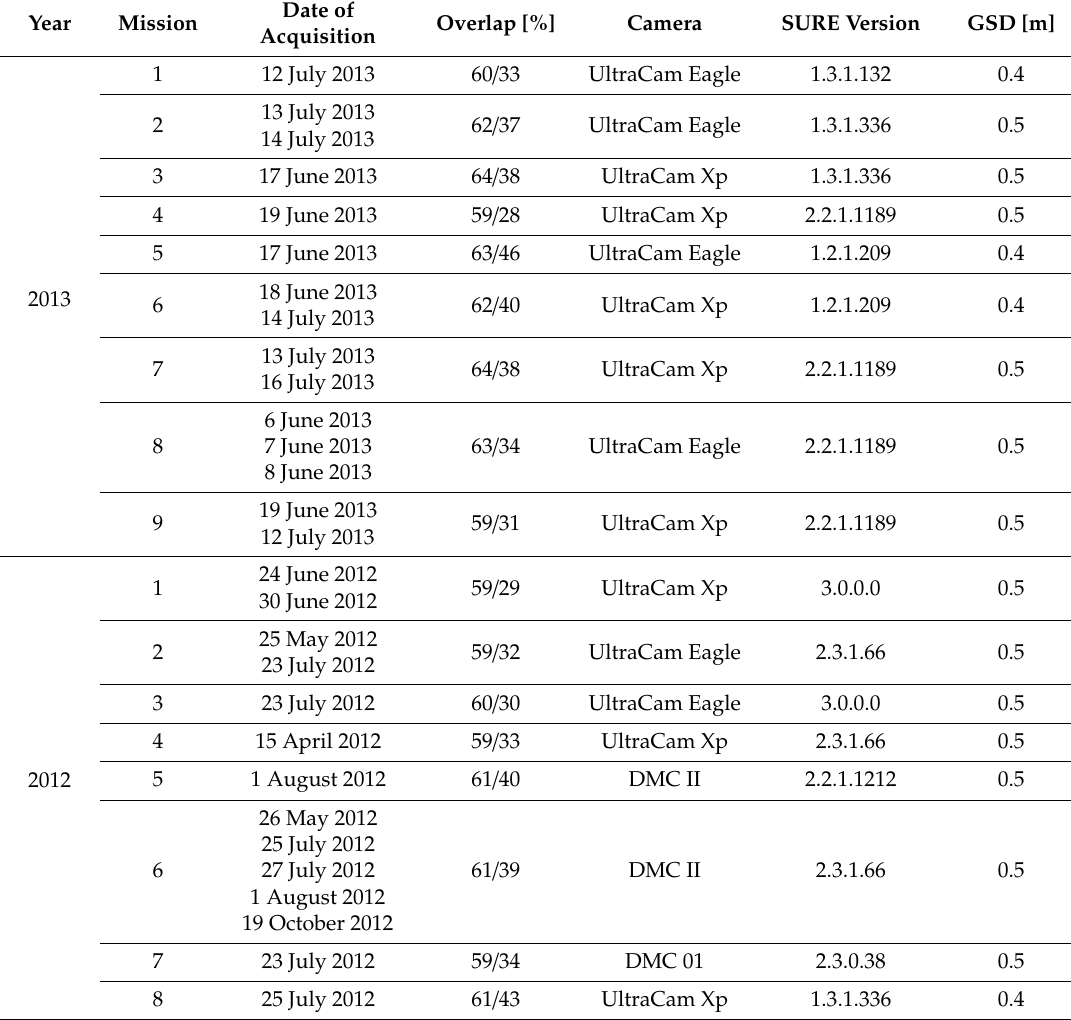
Table A1. Settings of the image